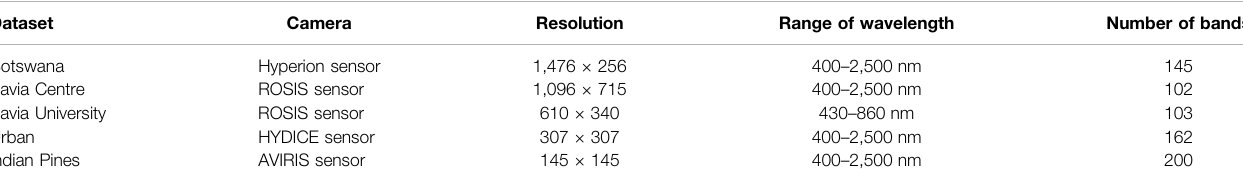
TABLE 1 | Remote sensing datasets for hyperspectral image